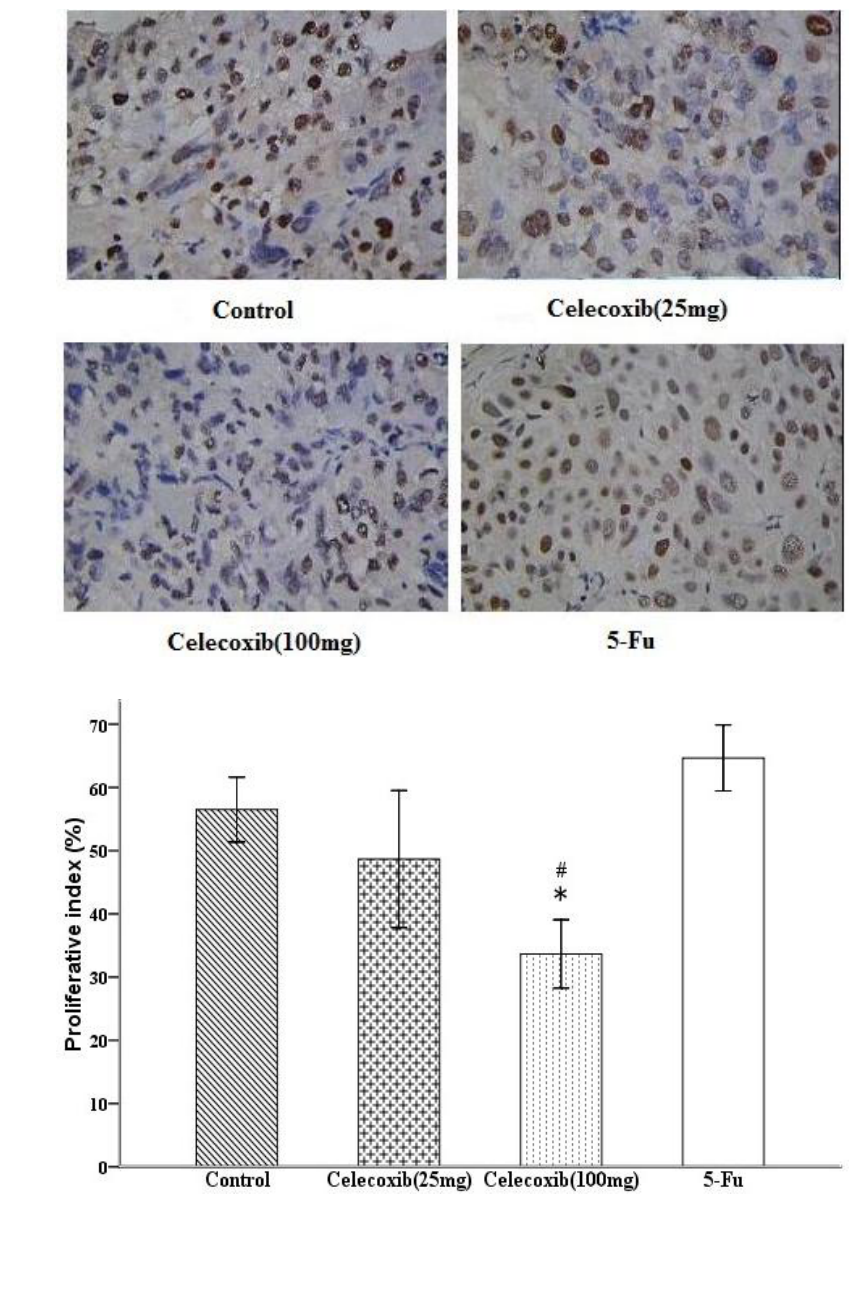
Figure 3. COX-2 inhibitor effect on the proliferation of tumors: ( A ) representative photomicrograph of Ki-67 staining of tumor tissue; ( B ) proliferation index. Quantitative data for the proliferation index is shown as percent of Ki-67-postive cells. Proliferation index illustrates the proliferation inhibition of Celecoxib on tumors. * P < 0.05 compared with control, # P < 0.05 compared with low-dose Celecoxib treated group, error bars indicate